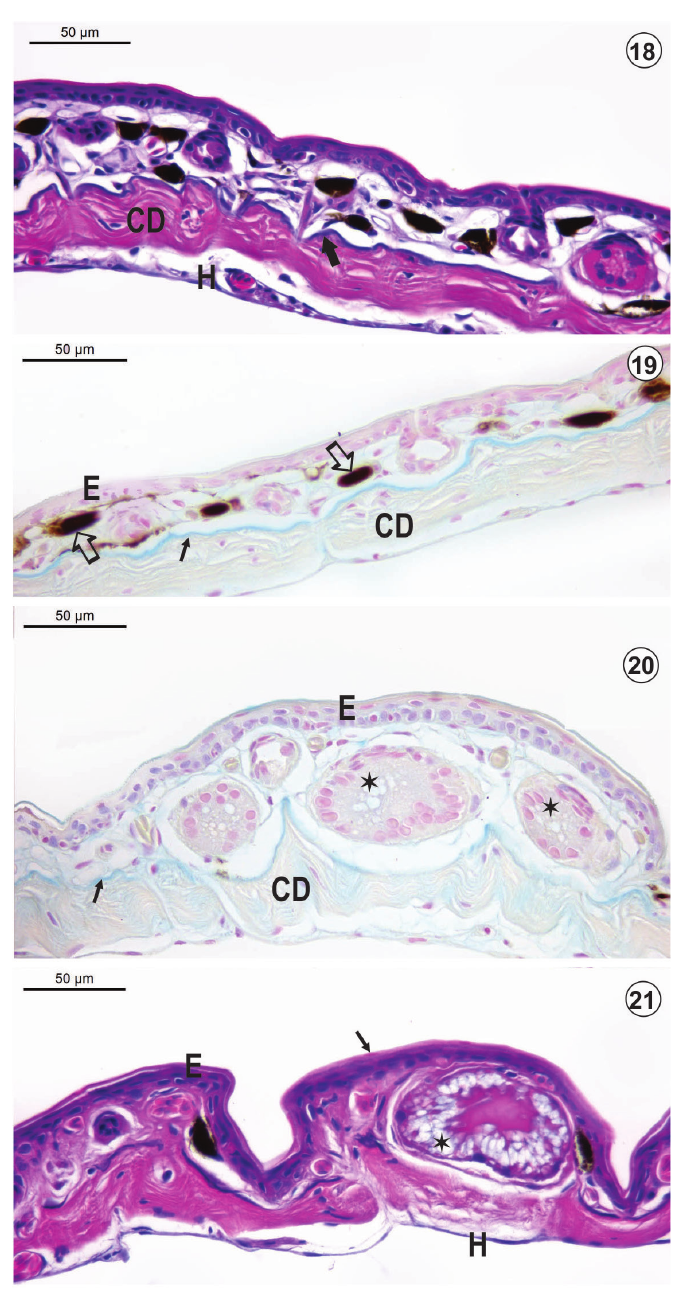
Figures 18–21. Light micrograph of the integument of O. flavoguttata : (18) Dorsal region (HE-staining); (19) Dorsal region (AB-method); (20) Ventrolateral region (HE-staining) (21) Ventral region (HE-staining). The epidermis (E) is partially keratinized, and the outermost cell layer exhibits the nuclear profiles ( → ). Melanophores ( _ ) occur in the spongious dermis of both dorsal and ventrolateral regions; they are more frequent in the dorsal integument. Small clusters of apocrine glands with heterogeneous content occur in the ventrolateral integument. In the ventral region, the lipid content ( ë ), mixed with basophilic material, is easily visualized in the apocrine glands (Fig. 21). In the dorsal region, the EK-layer (  ) is continuous, but discontinuous in the ventrolateral integument, being less alcianophilic in the ventral region when compared to other integument regions. CD = compact dermis; H = hypodermis. ZOOLOGIA 34: e20176 | DOI: 10.3897/zoologia.34.e20176 | September 18, 20176 /